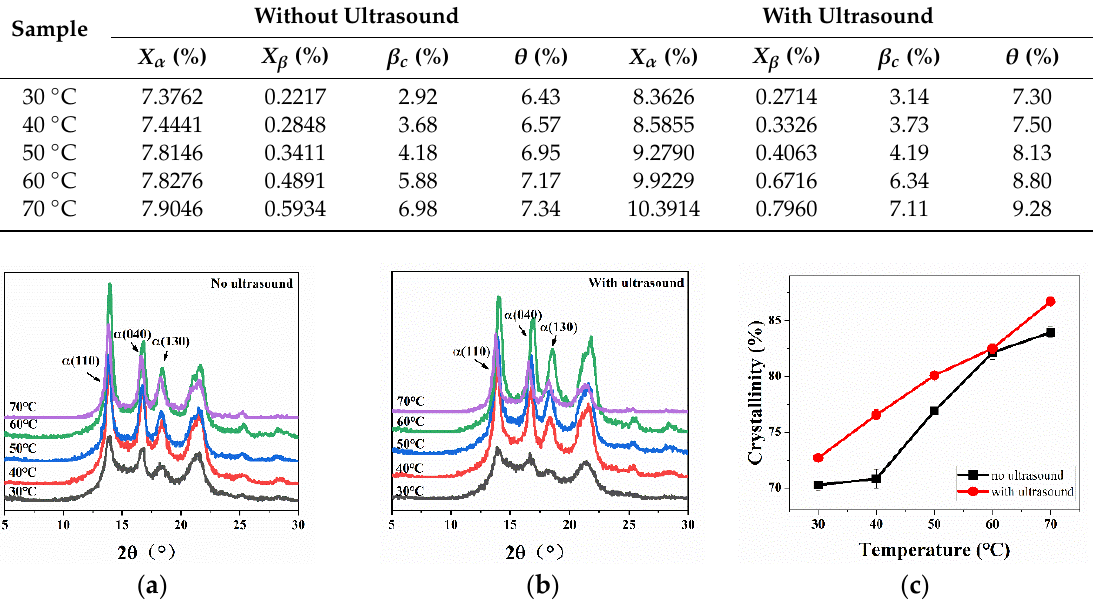
Figure 9. ( a ) X-ray diffraction (XRD) atlas of pure PP without ultrasound. ( b ) XRD atlas of pure PP with ultrasound. ( c ) The w c,x values of pure PP without ultrasound and with ultrasound.